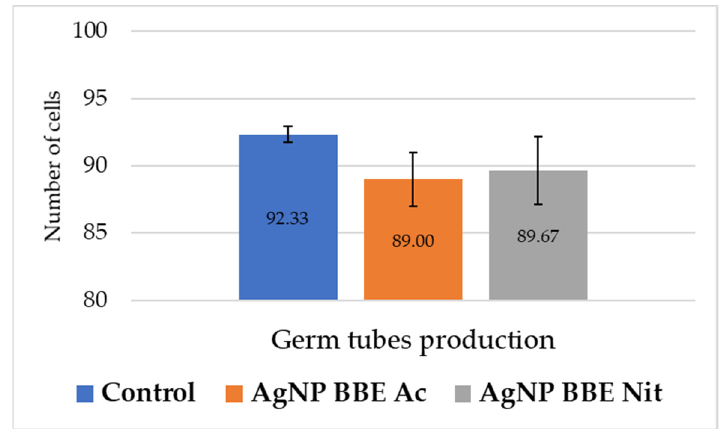
Figure 3. AgNP BBEs’ effect on C. albicans germ tube production.